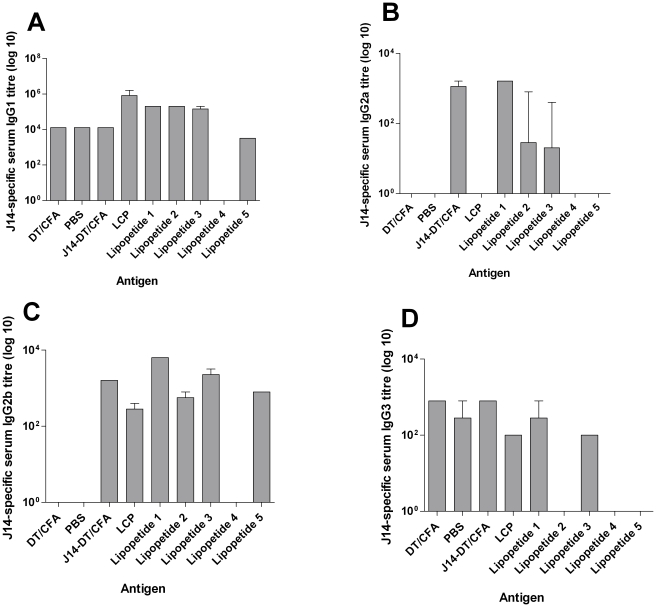
Isotypes of J14-specific serum IgG titers (log10) present in the final bleed (day 60) after primary immunization.Bars represent the titer for pooled sera obtained from each group. Error bars represent standard error of mean.